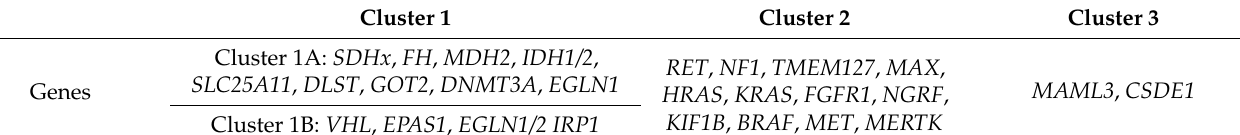
Table 1. Genes and hallmarks of tumourigenesis according to molecular clusters.